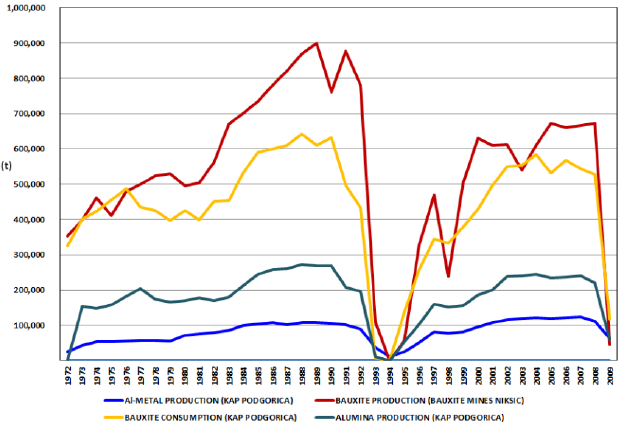
Figure 18. Bauxite production and consumption, alumina and aluminium production in Montenegro, 1972–2009, (t). The total quantities of bauxite residue amount to about 7.5 million tons in basins A and B in the Aluminium Factory Podgorica. The calculation of the average content of main and other oxides, trace elements and rare earth elements of 19 composite samples are given in Table 12. Table 12. The average content of major oxides and trace elements in bauxite residue from basins A and B in Aluminium factory—Podgorica (KAP). REEBAUX [6].